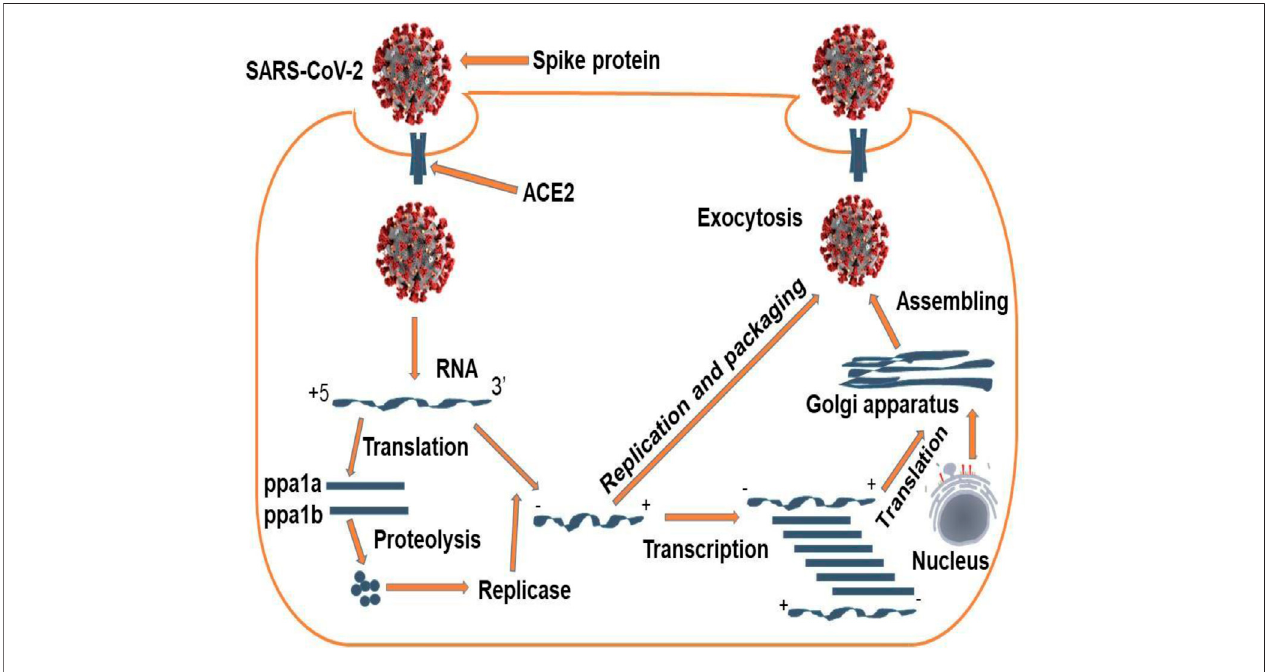
FIGURE 1 | Life circle of SARS-CoV-2 in a host ’ s cell.